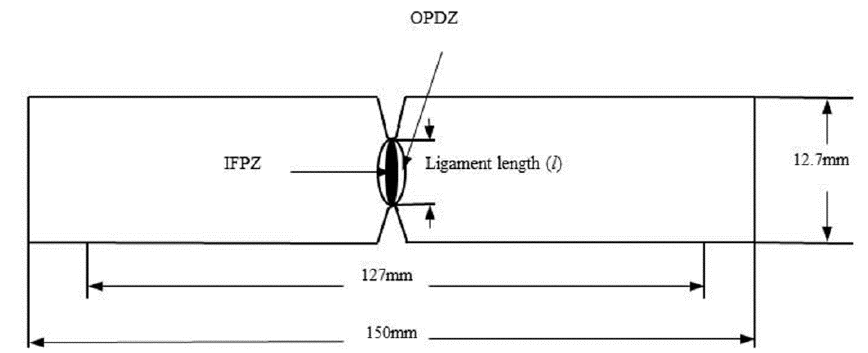
Figure 1. Schematic of double-edge notched impact specimen based on essential work of fracture (EWF). IFPZ and OPDZ denote inner fracture process zone and outer plastic deformation zone, respectively.